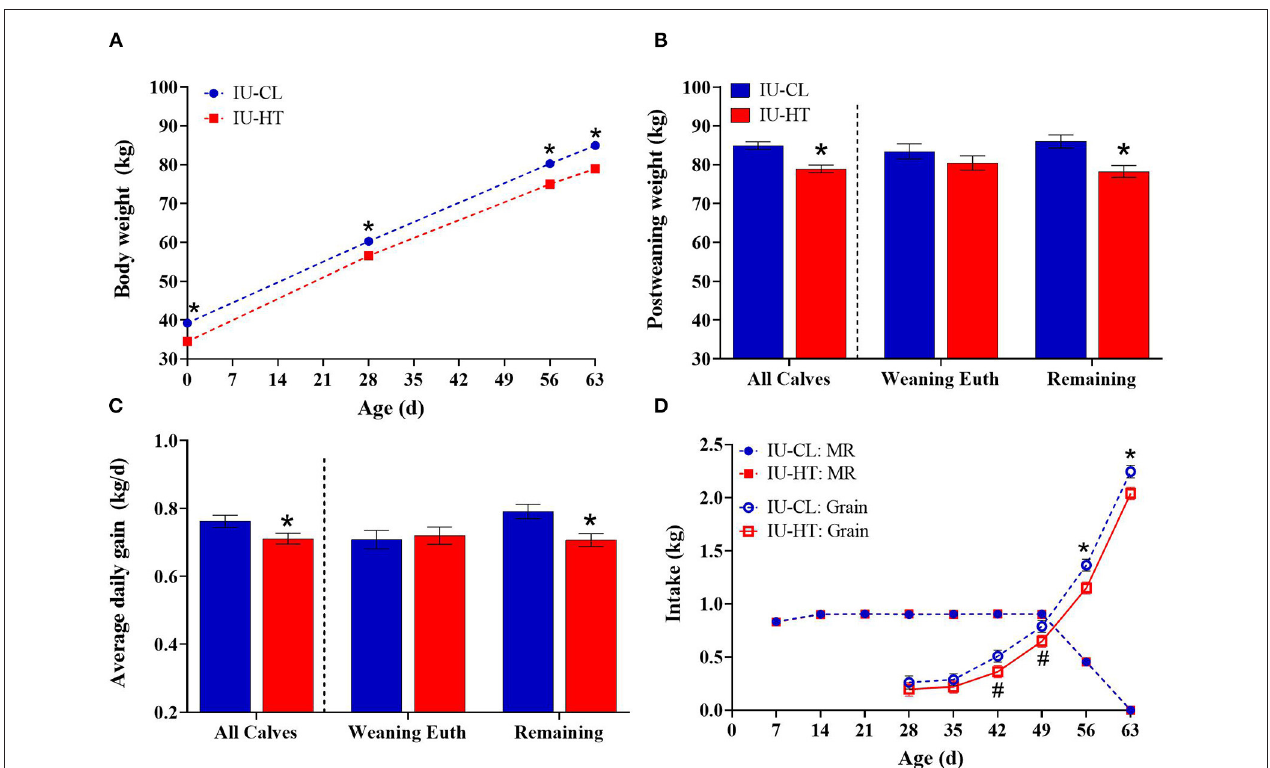
FIGURE 3 | Growth parameters and feed intake of heifers exposed to late-gestation in utero heat stress (IU-HT, red bars/symbols, n = 36) or cooling (IU-CL, blue bars/symbols, n = 37). (A) Body weights (BW) from birth (d 0) to post-weaning (d 63). Post-weaning BW (B) and average daily gain from 0 to 63 d (C) depicted as all heifers per treatment plus subgroups of heifers euthanized at weaning ( n = 8 per in utero treatment) and remaining calves ( n = 20, IU-HT; n = 21, IUCL). (D) Milk replacer (MR, closed symbols) and starter grain concentrate (open symbols) intake from 1 to 9 weeks of age. Data is presented as LSM ± SE for the main effect of in utero treatment (B,C) or treatment × time (A,D) . *Indicates significance ( P ≤ 0.05) and # indicates tendency (0.10 ≥ P > 0.05).